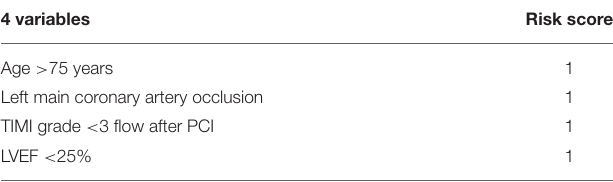
TABLE 3 | Early risk